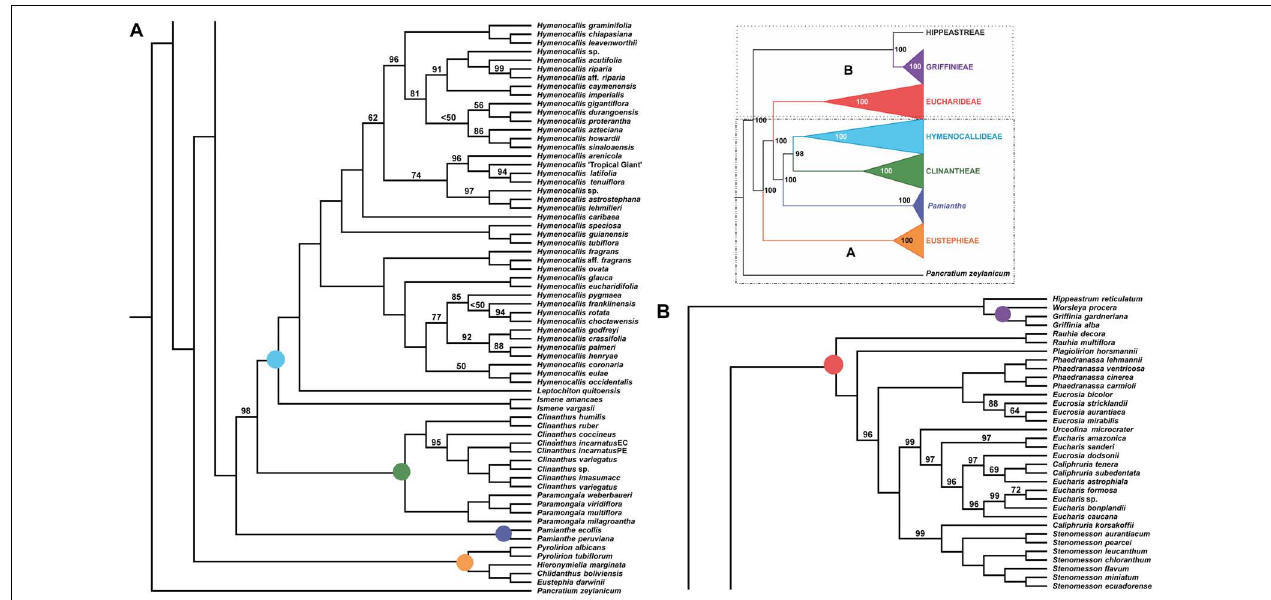
FIGURE 2 | Best tree from maximum likelihood analysis of partitioned 524 nuclear gene supermatrix of the Andean tetraploid clade of Amaryllidaceae subfam. Amaryllidoideae, with bootstrap percentages < 100 shown above branches (all unmarked branches have 100% BP). The tree is divided into two sections (A,B) for readability; refer to the colored inset (a cartoon of the tree collapsed to the tribal level) as a guide. Colored circles at the nodes in the full tree conform to clade colors in the